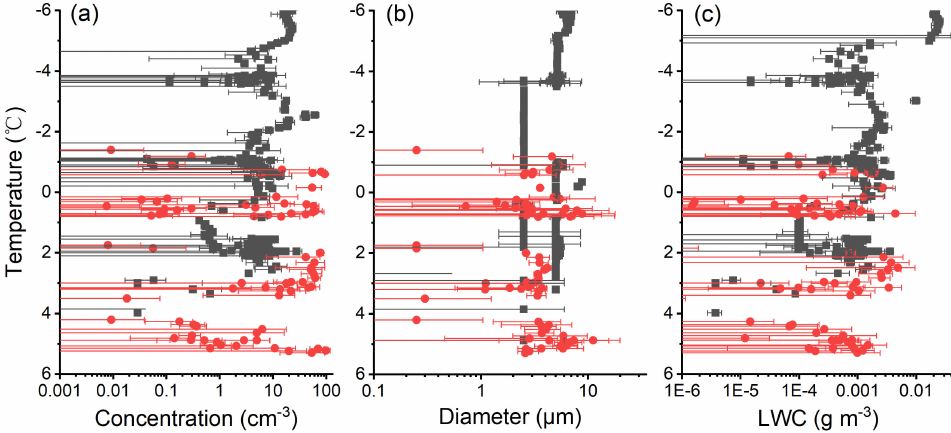
Figure 4. The same as in Figure 3, the SF variation in ( a ) the cloud droplet concentration, ( b ) average diameter, and ( c )